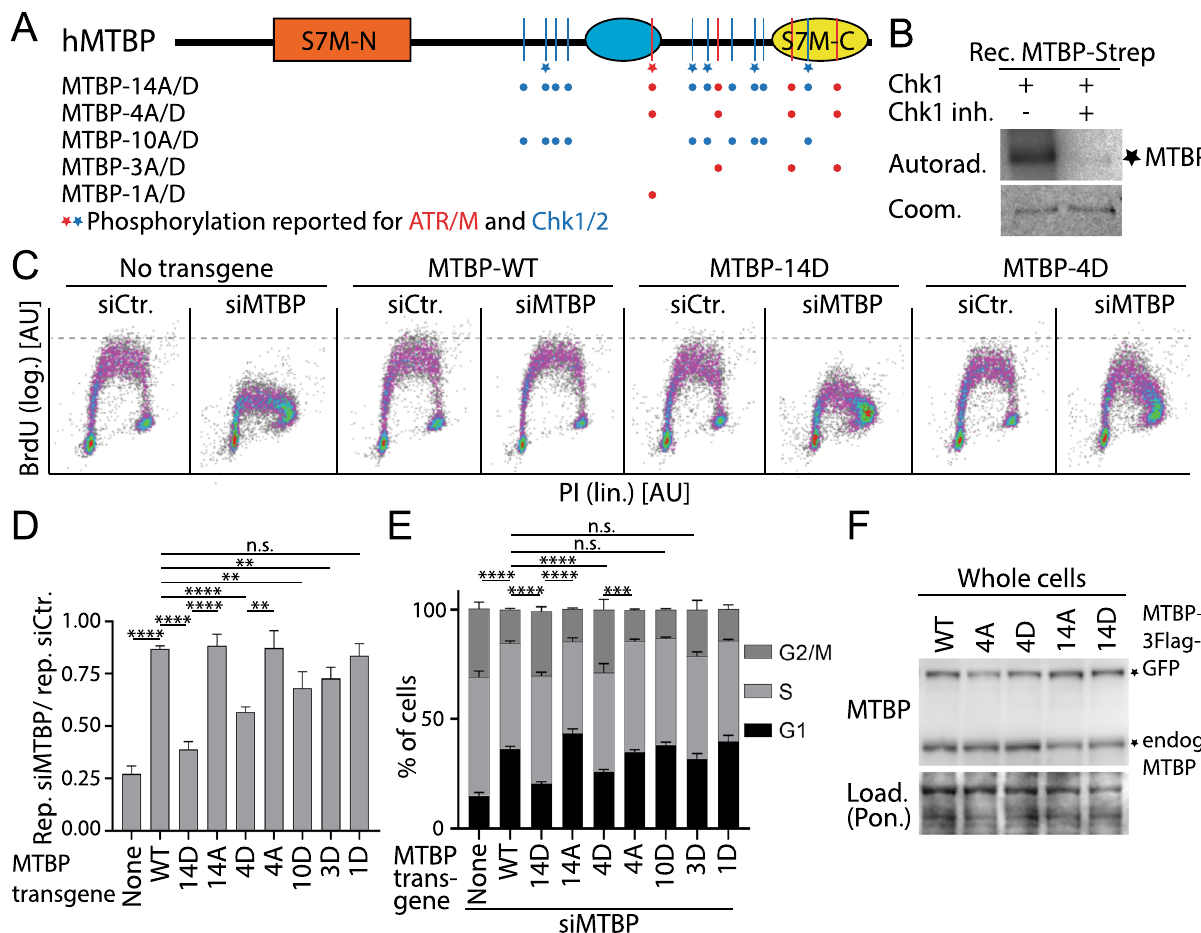
Figure 2. Phosphorylation of MTBP at checkpoint kinase consensus sites inhibits genome replication. ( A ) Domain architecture of human MTBP with mutated consensus phosphorylation sites for ATR/M (S/T-Q, red) (amino acids T687, S761, S827, S858) and Chk1/2 (R/K-x-x-S/T, blue) (amino acids T531, T577, S579, T611, S738, S755, T781, T804, S808, S846). *, reported phosphorylations (phospho-site.org). Mutations to aspartate (D) or alanine (A) introduced in MTBP are indicated by colour-coded dots: MTBP-14A/D, 14 ATR/M and Chk1/2 mutated; 4/3/1A/D, all four, three or one ATR/M site(s) mutated; 10A/D, Chk1/2 sites mutated. ( B ) Chk1 in vitro phosphorylation of MTBP. Recombinant 6His-Treslin/TICRR-1-1258-MTBP-Strep was incubated with Chk1 in the presence of γ ‐ 32 P ‐ ATP and DMSO or Chk1 inhibitor AZD7762 and detected by autoradiography. Coomassie staining controlled loading (Load.); Rec., recombinant. ( C ) Flow cytometry density plots of HeLa Flip-In T-Rex cells expressing siMTBP-resistant C-terminally 3xFlag-TEV2-GFP-tagged MTBP- wild type (WT), MTBP-14D, MTBP-4D or no transgene, treated with control siRNA (siCtr) or siRNA against MTBP (siMTBP) and doxycycline, stained with anti-5 bromo-2 ′ deoxyuridine (BrdU) after pulse-labelling and with propidium iodide (PI). Log./lin., logarithmic/linear scale; [AU], arbitrary units. MTBP-14D; MTBP-4D mutants, see A) ( D , E ) Quantification of replication activity ( D ) or cell cycle distribution ( E ) using BrdU-PI- flow cytometry as described in C. Error bars, SEM. n = 11 (no transgene); 9 (MTBP-WT); 8 (MTBP-14D); 3 (MTBP-14A); 8 (MTBP-4D); 5 (MTBP-4A); 3 (MTBP-10D); 4 (MTBP-3D); 3 (MTBP-1D); MTBP mutants: see A; significance tests: parametric, unpaired, two tailed student t-test. Significance tests in E) indicate differences in G2/M population distribution. ( F ) Whole cell lysates of stable cell lines described in C were analysed by immunoblotting using anti-MTBP (12H7), and Ponceau (Pon.) normal BrdU-PI profiles regardless of treatment with control (siCtr) or MTBP siRNA (siMTBP) (Fig. 2C–E). In contrast, cells expressing MTBP-14D and no-transgene control cells had strongly reduced replication signals upon siMTBP treatment to 39% and 27%, respectively, compared to 87% with MTBP-WT (Fig. 2C,D). MTBP- 14D and control cells also had increased G2/M populations with a concomitant dramatic drop of the G1 popula- tion (Fig. 2E). Flow cytometry-determined G2/M populations often increase upon compromising replication as a consequence of delays in G2 and M phases. The defects with MTBP-14D reflected an effect of phosphorylation at these sites rather than unspecific MTBP inactivation due to the mutations, because MTBP-14A behaved like MTBP-WT (Fig. 2D,E). Expression levels of MTBP-14D, 14A and WT were similar (Fig. 2F). We then separated the mutations of MTBP-14A/D. Mutating the four ATR/M sites to D (MTBP-4D), but not to A (4A) (Fig. 2A),